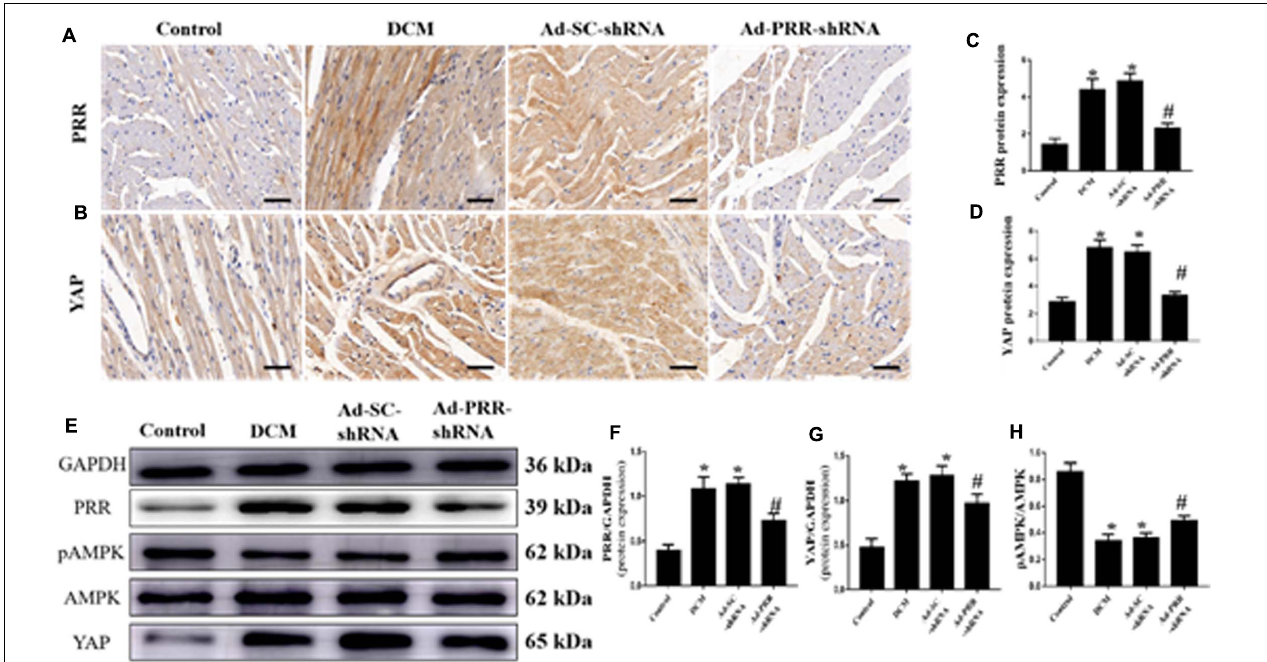
FIGURE 1 | PRR silencing decreased PRR and YAP expression and increased the phosphorylation of AMPK in rats with diabetic cardiomyopathy ( n = 5). (A,B) Representative immunohistochemical staining of PRR and YAP in the 4 groups (scale bar = 20 µ m). (C,D) Quantitative analysis of the YAP protein expression shown in panels (A,B) . (E) western blot analysis of PRR, pAMPK, AMPK, and YAP protein expression in the 4 groups. (F,G) Quantitative analysis of the PRR and YAP protein expression shown in panel (E) . (H) Quantitative analysis of the pAMPK/AMPK shown in panel (E) . * p < 0.05 versus the control group; # p < 0.05 versus the Ad-SC-shRNA